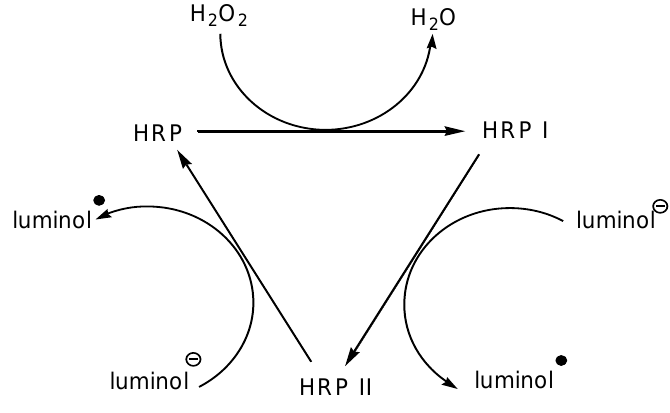
Figure 1. Control experiments by flow of 100  L of 0 ng/mL CEA without enzyme-labeled, 0.1 mg/mL BSA, 2 mg/mL HRP and 9:1 of HRP-labeled anti-CEA and CEA standard solution containing 0 ng/mL after being incubated at room temperature for 25 min. The substrate solution is 0.5 mM luminol + 4 mM H